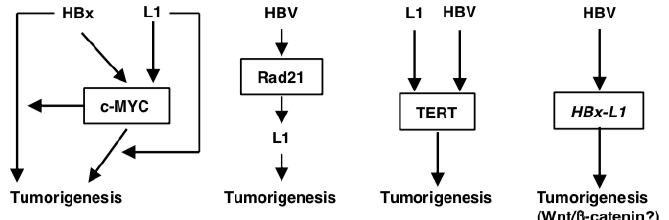
Figure 2. HBV- and HCC-related genes in L1 biology. HBx activates c-MYC, and HBx and c-MYC synergistically promote tumorigenesis. L1 de novo insertions were preferentially localized near the c-MYC gene, which may upregulate gene expression. L1 plays a role in genomic rearrangement in MYC-induced oncogenesis. Rad21 is upregulated in HBV-related HCC, which drives L1 expression. Upregulation of L1 may enhance L1 retrotransposition and thereby cancer development. HBV and L1 sequences are reportedly inserted into the TERT gene locus. The insertions upregulate the gene expression, which can affect tumorigenesis. The HBx sequence is inserted into L1 loci, which generates HBx-L1 chimeric transcripts. HBx-L1 functions as a non-coding RNA that activates the oncogenic Wnt/ β -catenin pathway.